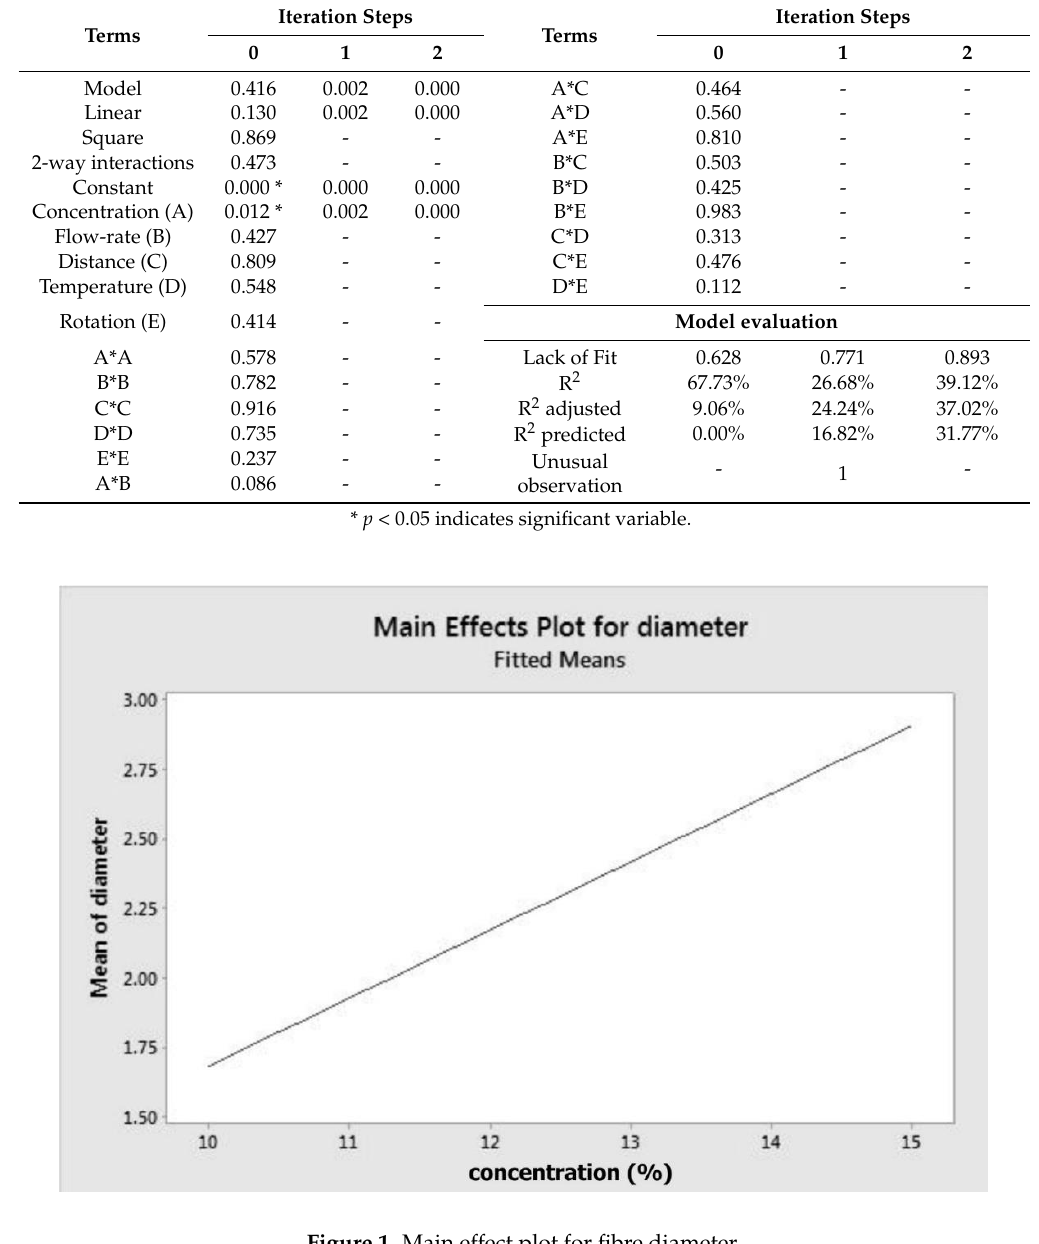
Table 3. Summary of response surface analysis for fibre diameter.